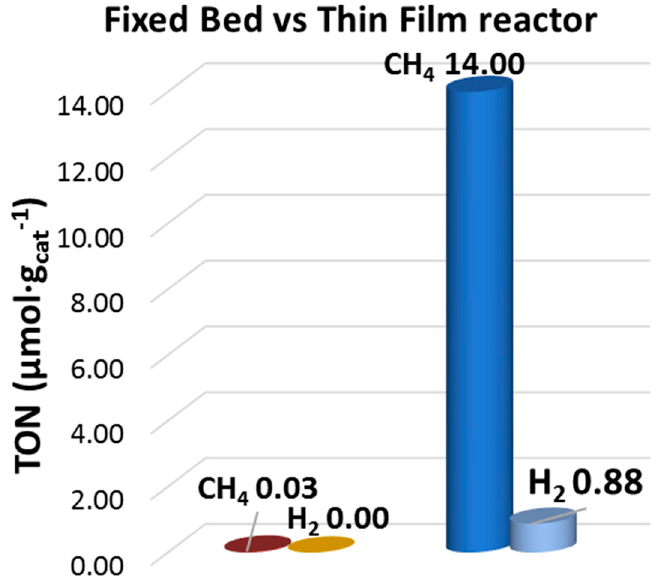
Figure 1. Benchmark titania photocatalytic activity in fixed bed and thin film reactors.